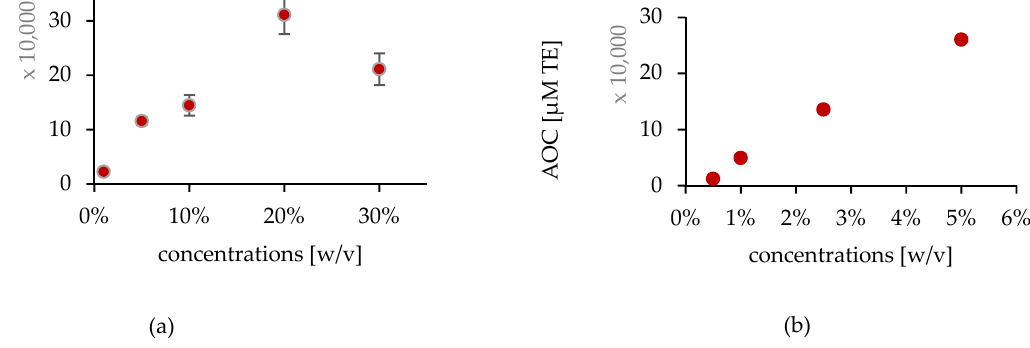
Figure 8. The in vitro AOC values using ORAC assay ( a ) for AA solutions (1–30% (w/v)), and ( b ) CoQ10 solutions (0.5–5% (w/v)).